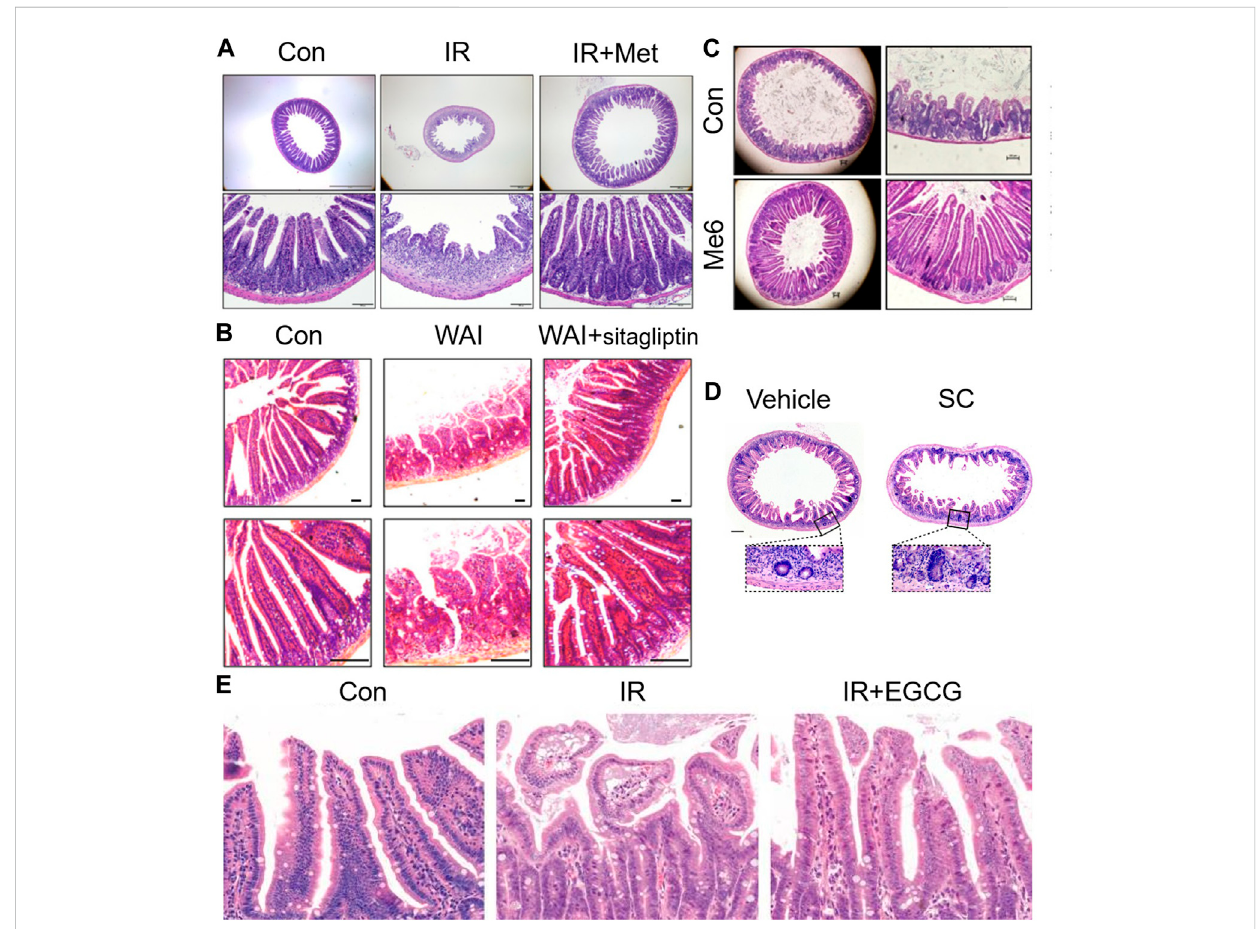
FIGURE 4 Therapeutic effects of drugs on radiation enteritis. (A) . Metformin increased villus length and crypt number after irradiation. (B) . Sitagliptin reduced theintestinaldamagecausedbyirradiation inmice. (C) .Me6TRENpromoted intestinal tissue regeneration after radiation injury. (D) .CBP/P300inhibitiors promoted the regeneration of crypts in vivo . (E) . EGCG administration reduces radiation-induced intestinal mucosal injury signi fi cantly by increasing the number of LGR5 + ISCs and Ki67 + crypt